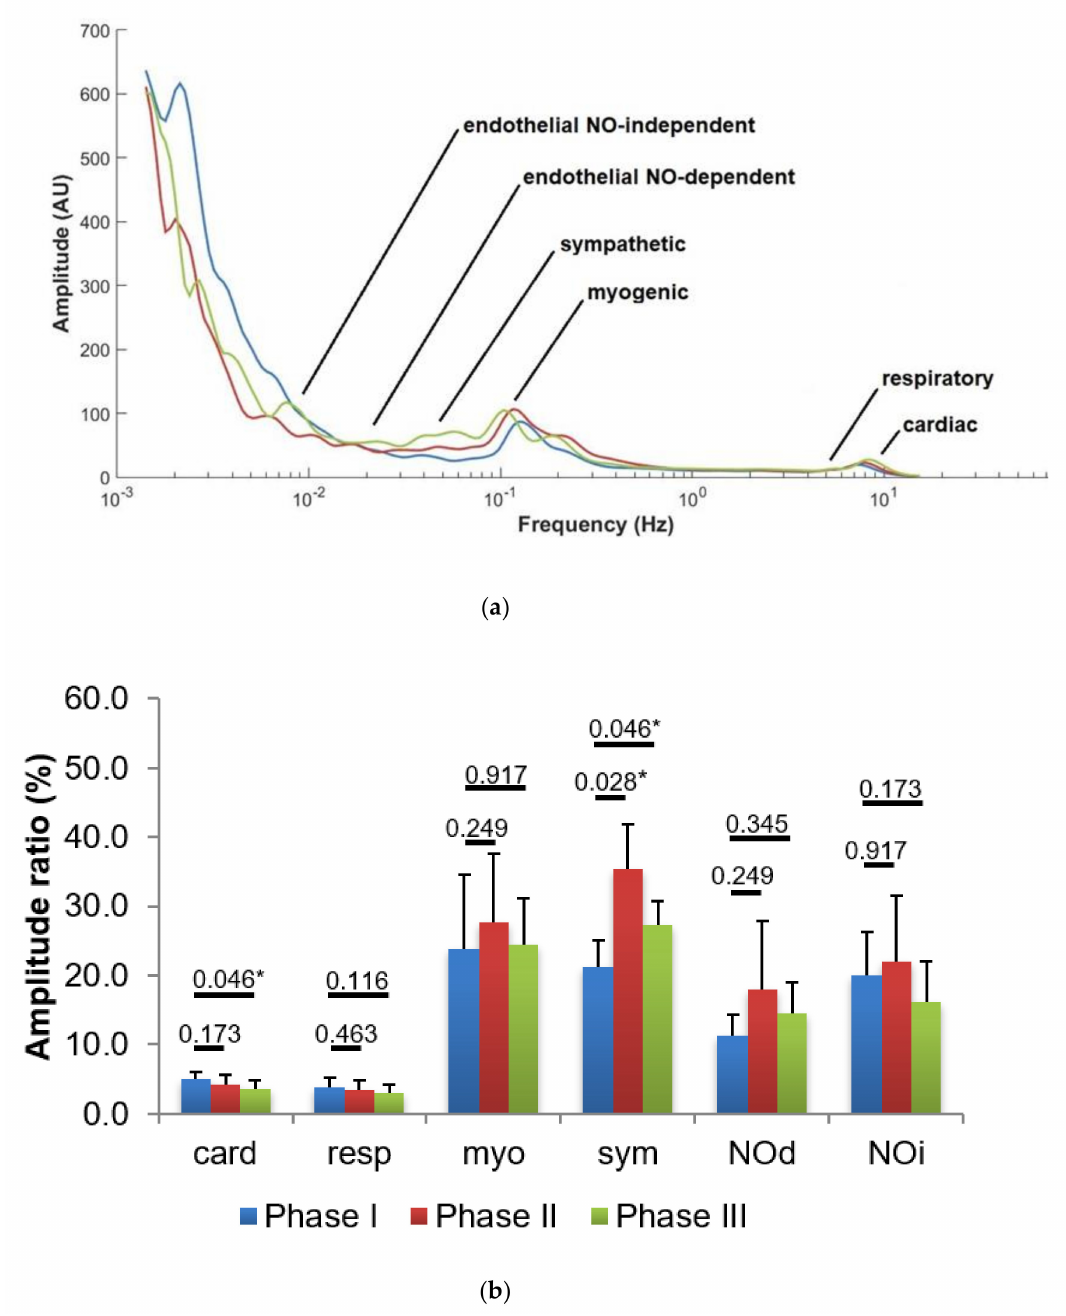
Figure 2. ( a ) mean spectrum of the laser Doppler flowmetry (LDF) signal for each phase of the protocol (Phase I, baseline—blue; Phase II, atenolol dose #1—red; Phase III, atenolol dose #2—green); ( b ) mean andstandarddeviationoftheamplituderatioforeachLDFcomponent(card—cardiac; resp—respiratory; myo—myogenic; sym—sympathetic; NOd—endothelial NO-dependent; and NOi—endothelial NO-independent). Statistical comparison ( p -values) versus baseline (Phase I) are shown (* p <